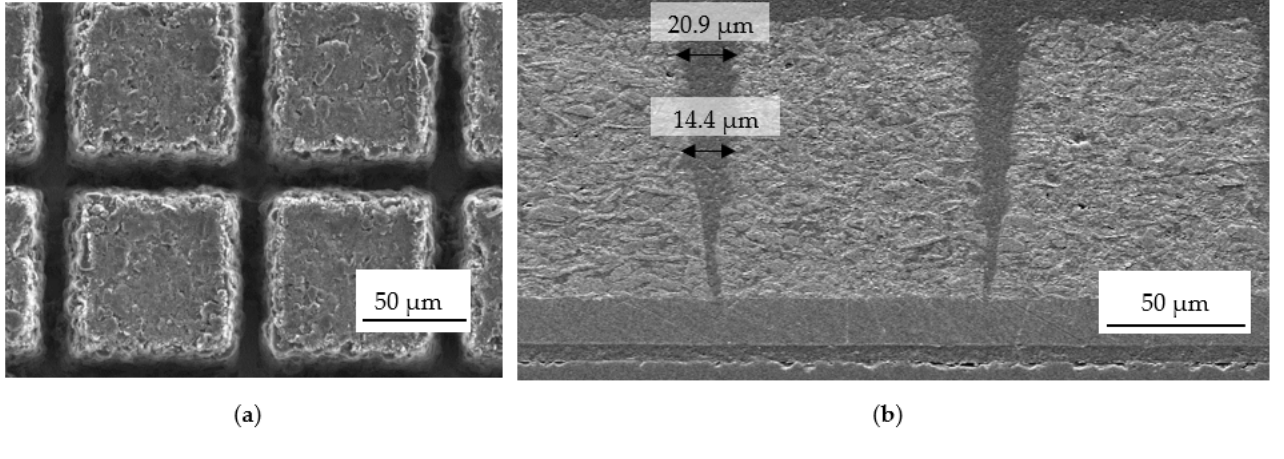
Figure 2. SEM images of laser-generated grid structures with a period of 100 µm: ( a ) top view and ( b ) cross section.